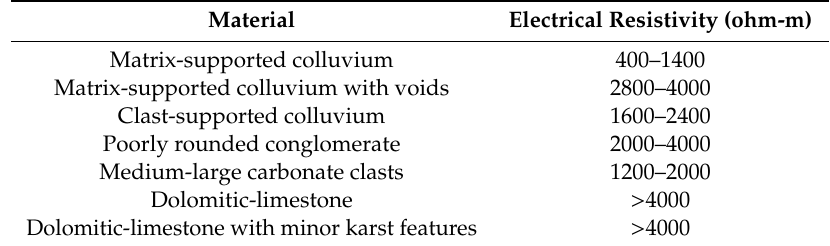
Table 4. The proposed electrical resistivity values corresponding to the geological units in the survey